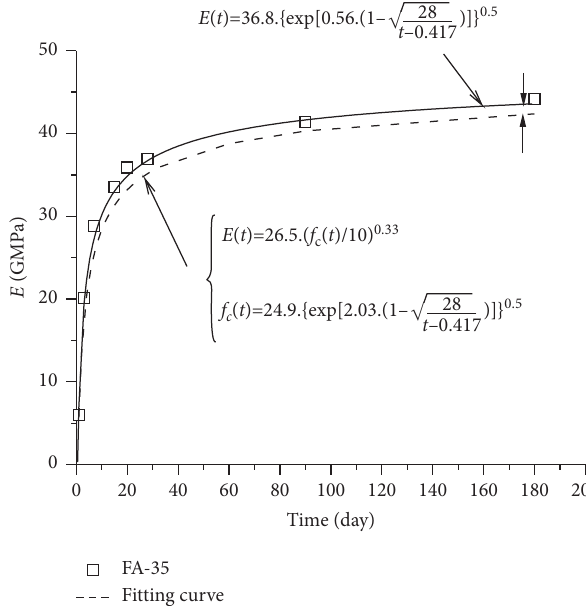
Figure 11: Comparison of the proposed model and test results in elastic